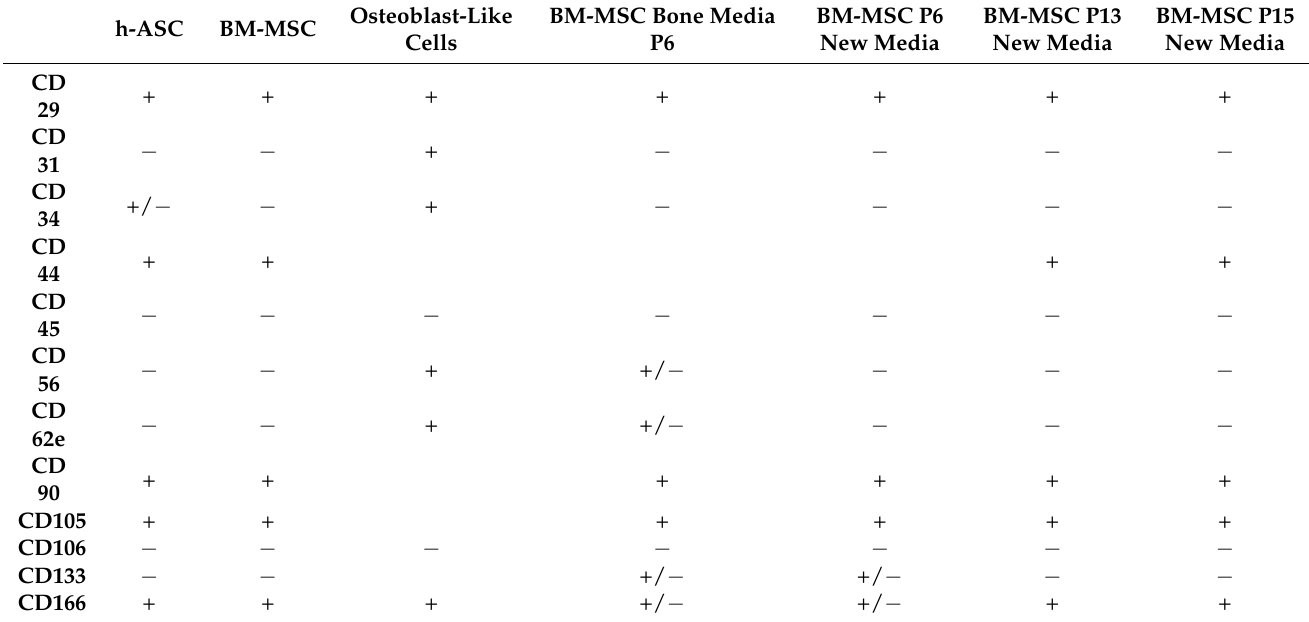
Figure 5. The CD markers expressed on HBMSCs. HBMSCs express CD29, CD90, CD105, CD106, and CD166 and lack expression of the hematopoietic lineage markers CD31, CD34, CD45, CD49D, CD56, and CD106. Table 1. The CD markers expressed on h-ASC, HBMSCs, osteoblast-like cells, HBMSC in traditional medium at P6 stage, BK medium at P6, P13, and P15 stages.